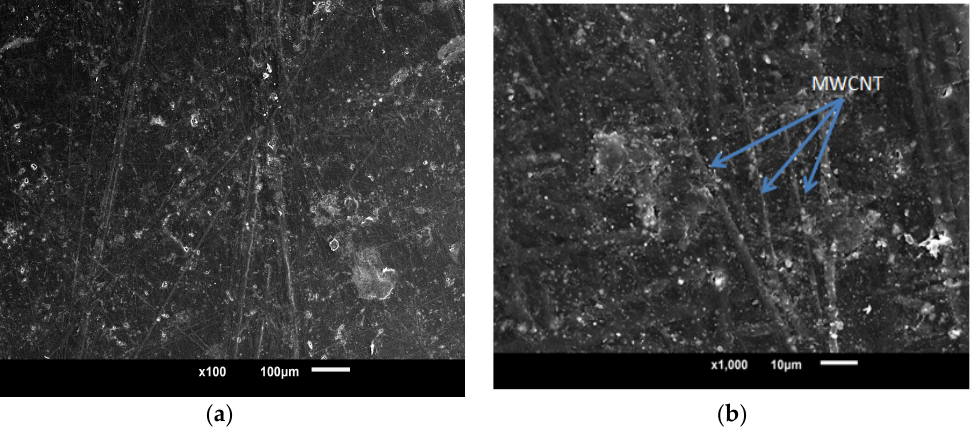
Figure 7. Scanning Electron Micrograph ( a ) SEM Micrograph ( b ) SEM micrograph at high